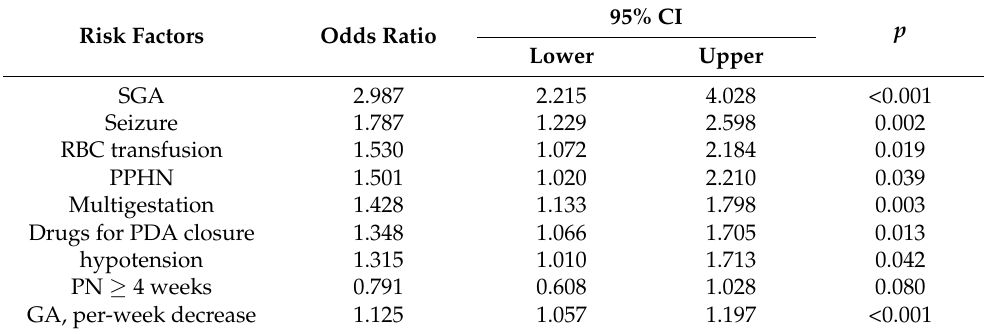
Table 2. Risk factors of thyroid dysfunction requiring L-thyroxine in very low birth weight infants.